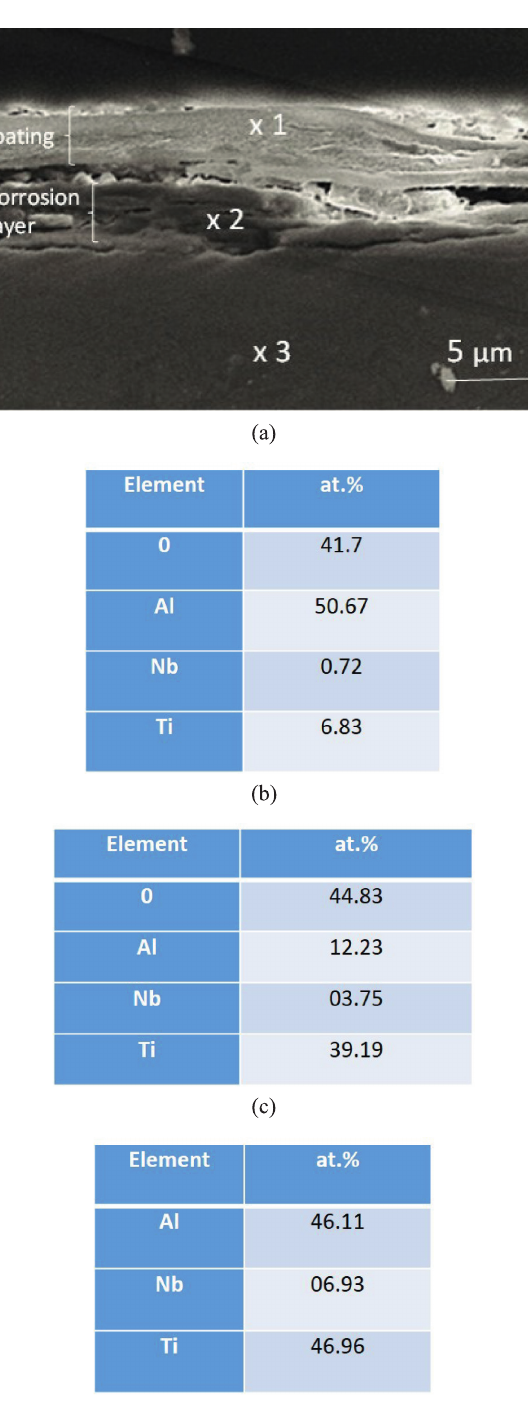
Fig. 6: (a) Cross-section of the scale formed on Ti-46Al-7Nb-0.7Cr- 0.1Si-0.1Ni coated with Al 2 O 3 after the oxidation in air, (b–d) chemical composition at points #1, #2 and #3